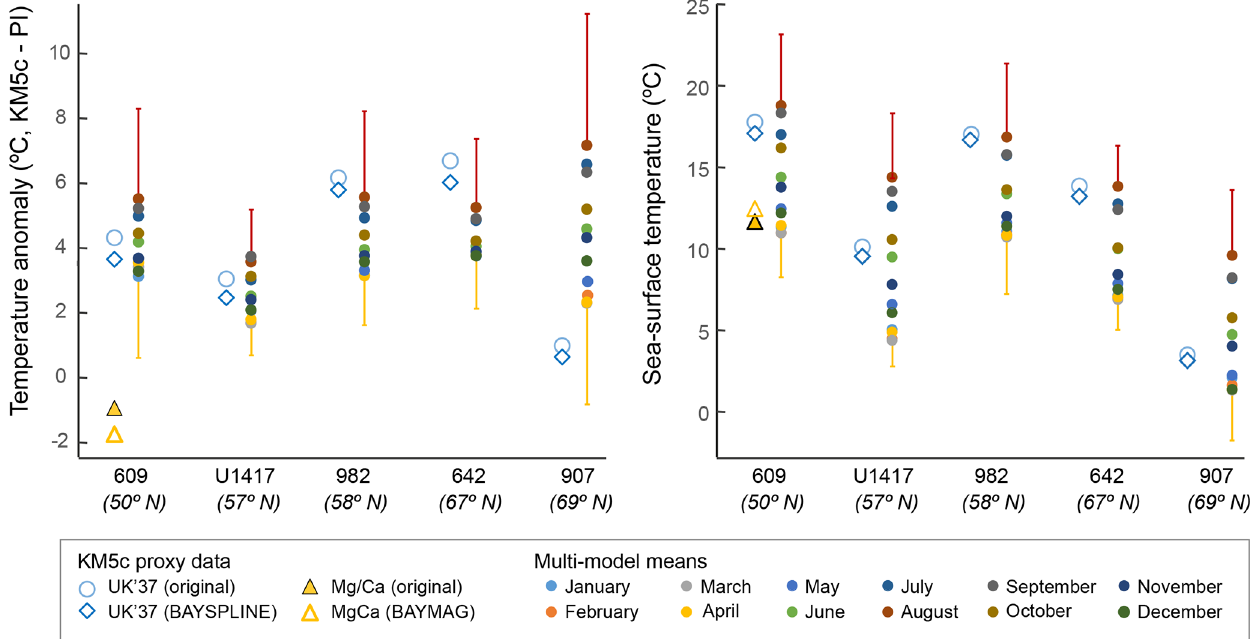
Figure 5. Investigating the potential seasonal signature recorded at high-latitude Northern Hemisphere sites ( > 50 ◦ N), ordered by increasing latitude from left to right. Note that Site U1417 is from the North Pacific, where BAYSPLINE explicitly assumes that a summer signal is recorded > 48 ◦ N. All other sites are from the Atlantic Ocean/Nordic Seas, where BAYSPLINE assumes an autumn signal > 45 ◦ N. The original calibration by Müller et al. (1998) proposes that mean annual SSTs are recorded. Standard deviations of the multi-model means are shown for August (red) and April (yellow), which tend to be the maxima and minima,